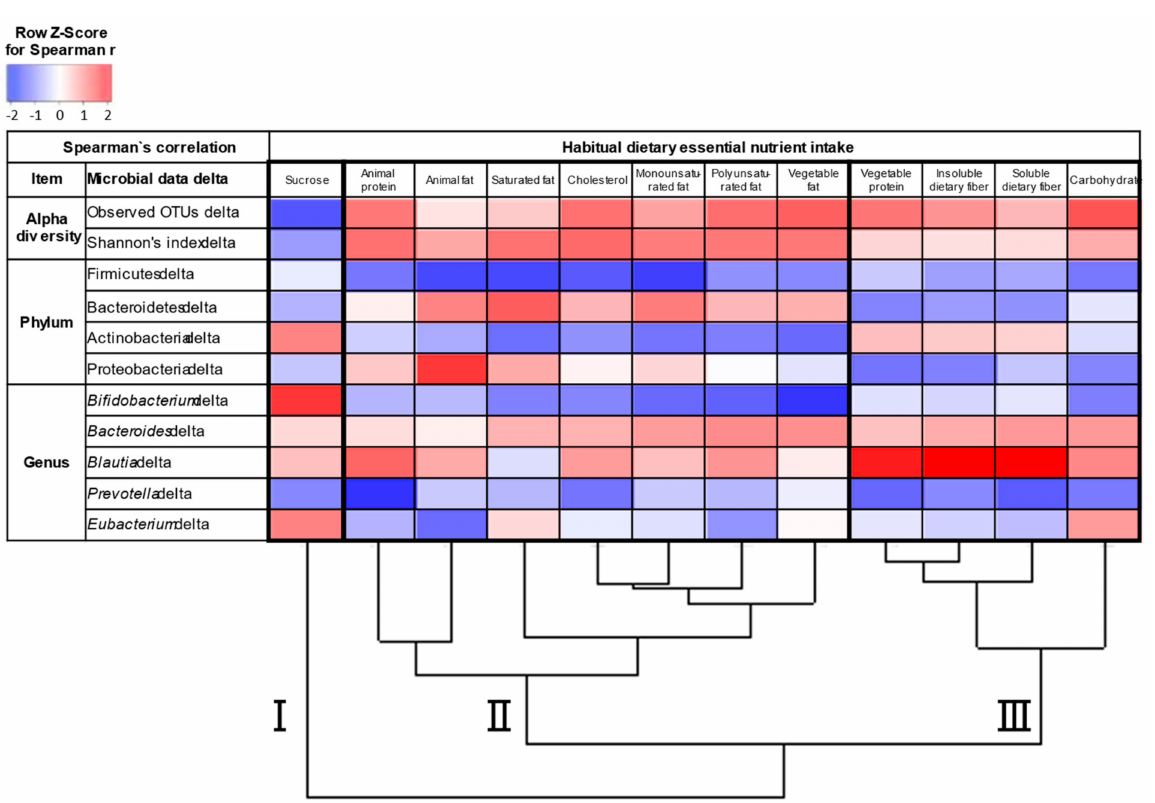
Figure 3. Association between habitual dietary intake and changes in microbial data. Spearman’s correlation of habitual dietary nutrient intake with the observed OTU number delta, Shannon index delta, and average relative abundance delta of the top four phyla and top five genera using a heatmap. The 12 dietary nutrient items were used for hierarchical clustering. The z-score based on the Spearman’s r between changes in the composition of the gut microbiome and habitual dietary nutrient intake is depicted from the lowest (blue) to the highest (red) according to the scale shown at the top. X delta = X after intervention − X before